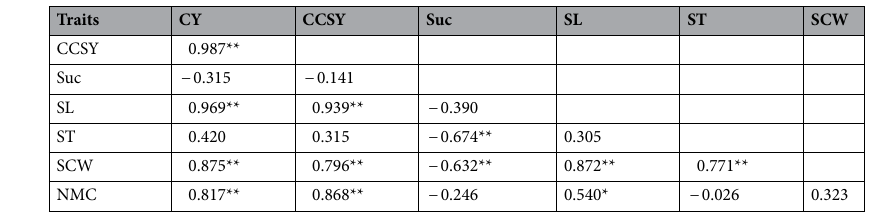
Table 2. Estimates of genotypic correlation between cane yield, CCS yield and component traits across ten test drought environments under drought stress in sugarcane. **significant at 1% level; *significant at 5% level. CY cane yield (t/ha), CCSY commercial cane sugar yield (t/ha), Suc sucrose percent at 12th month, SL stalk length (cm), ST stalk thickness (cm), SCW single cane weight (kg), NMC number of millable canes.